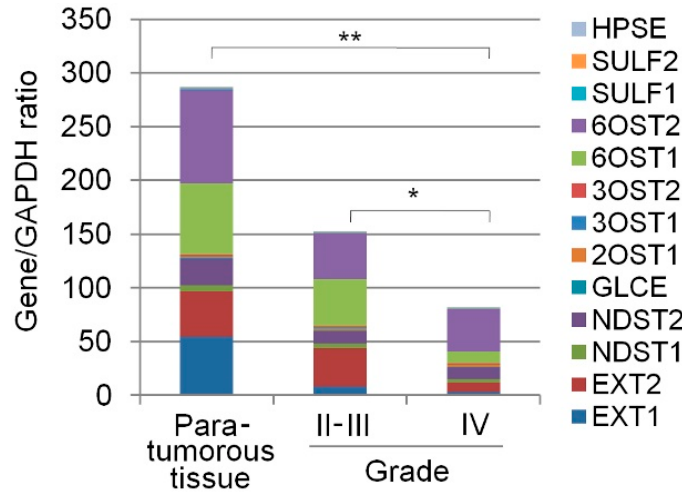
Figure 1. Transcriptional activity of the HS biosynthetic system in gliomas of different grades. The intensity of the amplified DNA fragments of HS biosynthesis-related genes was normalised to that of GAPDH . The stacked columns reflect the contribution of each gene to the total expression level. Control—para-tumourous brain tissuefrom the Grade II glioma patients. The stacked columns are based on the mean expression levels from triplicate experiments (Origin 8.5; OriginLab Corporation, Northampton, USA); * p < 0.01; ** p < 0.05.